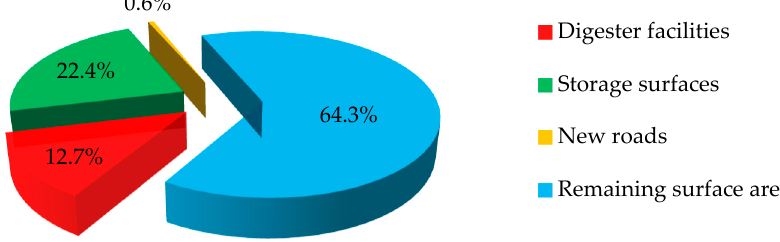
Figure 4. Percentage breakdown of the total area occupied by installations with their intended uses.